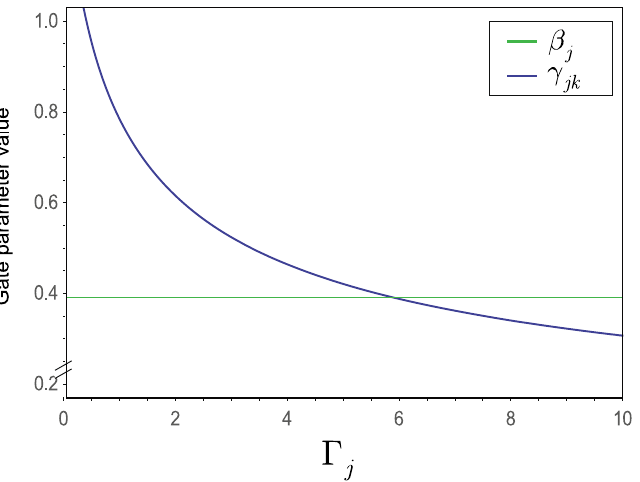
Figure 5. Gate parameter values β j and γ jk in function of Ŵ j for the maximization of ζ E